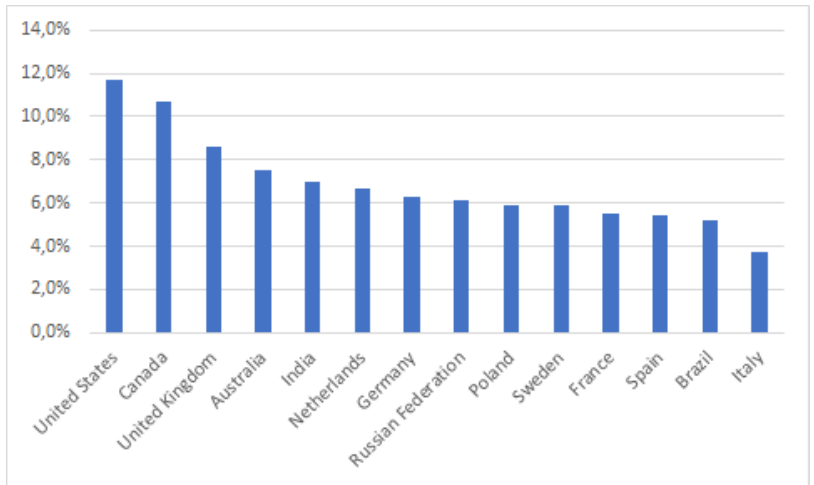
Figure 7. Gender minorities by country (adapted from